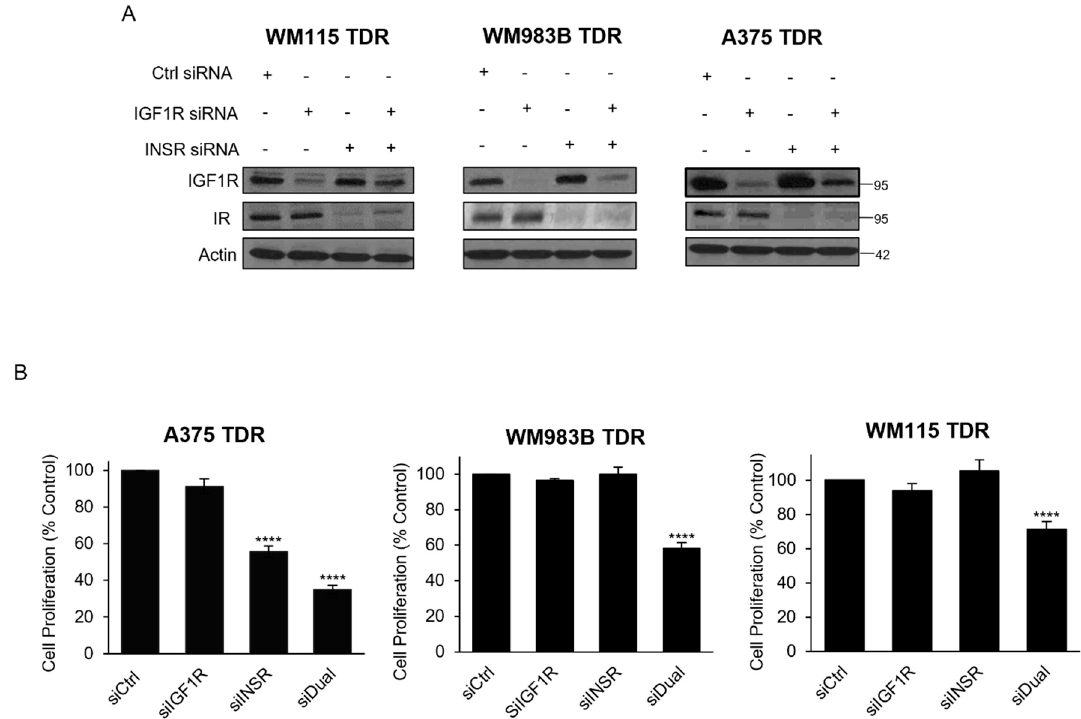
Figure 5. Dual knockdown of IGF1R and INSR reduces proliferation in TDR cells. ( A ) TDR cells were transfected with Ctrl siRNA, IGF1R siRNA, INSR siRNA, or combination of IGF1R and INSR siRNA for 72 h. Cells were collected, lysed, and analyzed for indicated antibodies. Actin was used as loading control. ( B ) TDR cells were transfected as described above, and plated and analyzed for MTT assay. **** p < 0.0001 by two ‐ tailed Student’s t ‐ test compared to siCtrl.